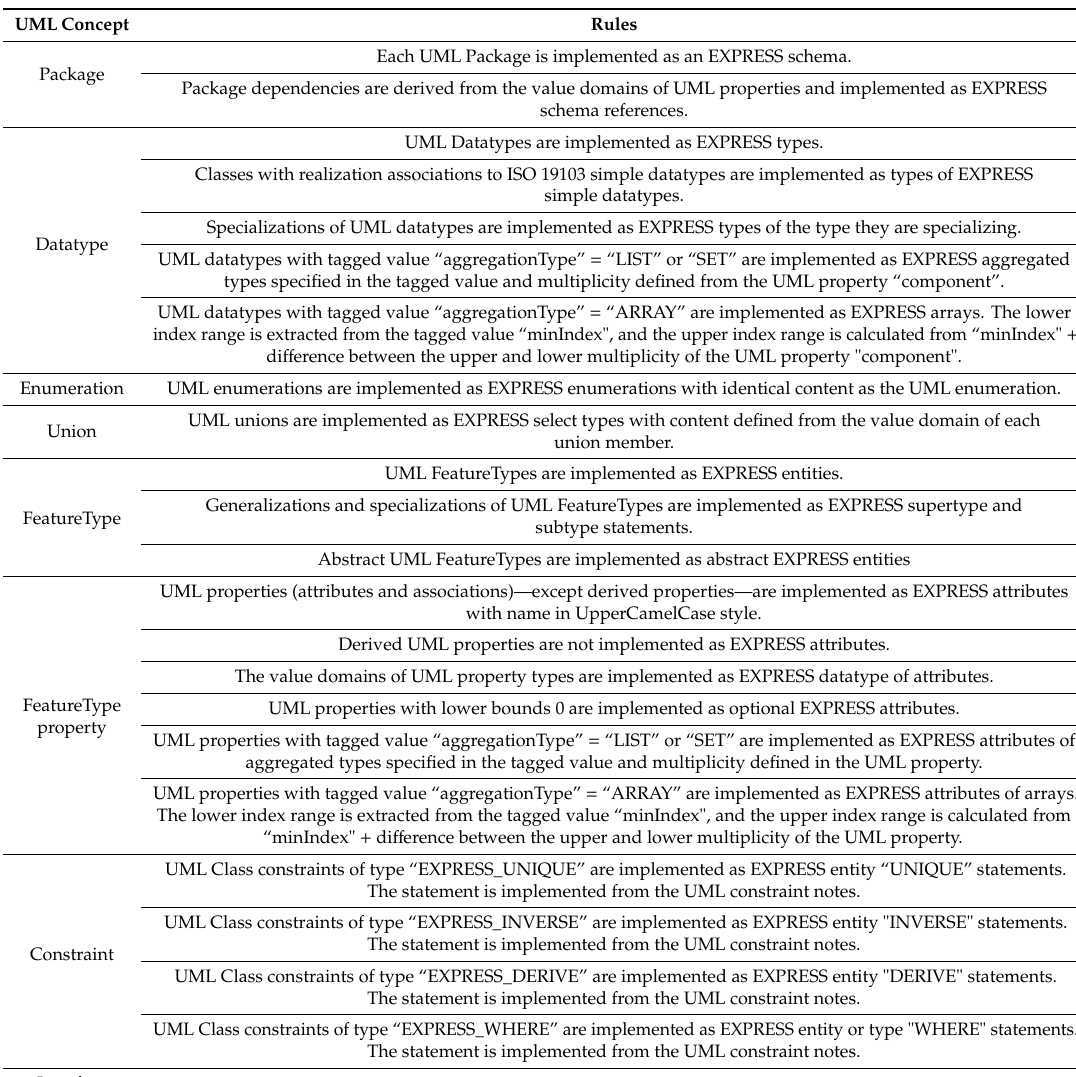
Table 10. Rules for conversion from UML to